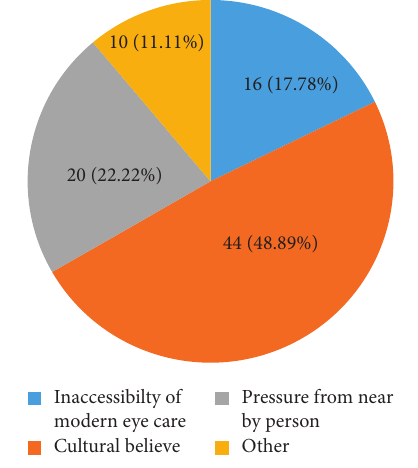
Figure 2: Pie chart that shows reasons for study participants to use traditional eye medicine among adult residents in Gondar city, North West Ethiopia, 2017.